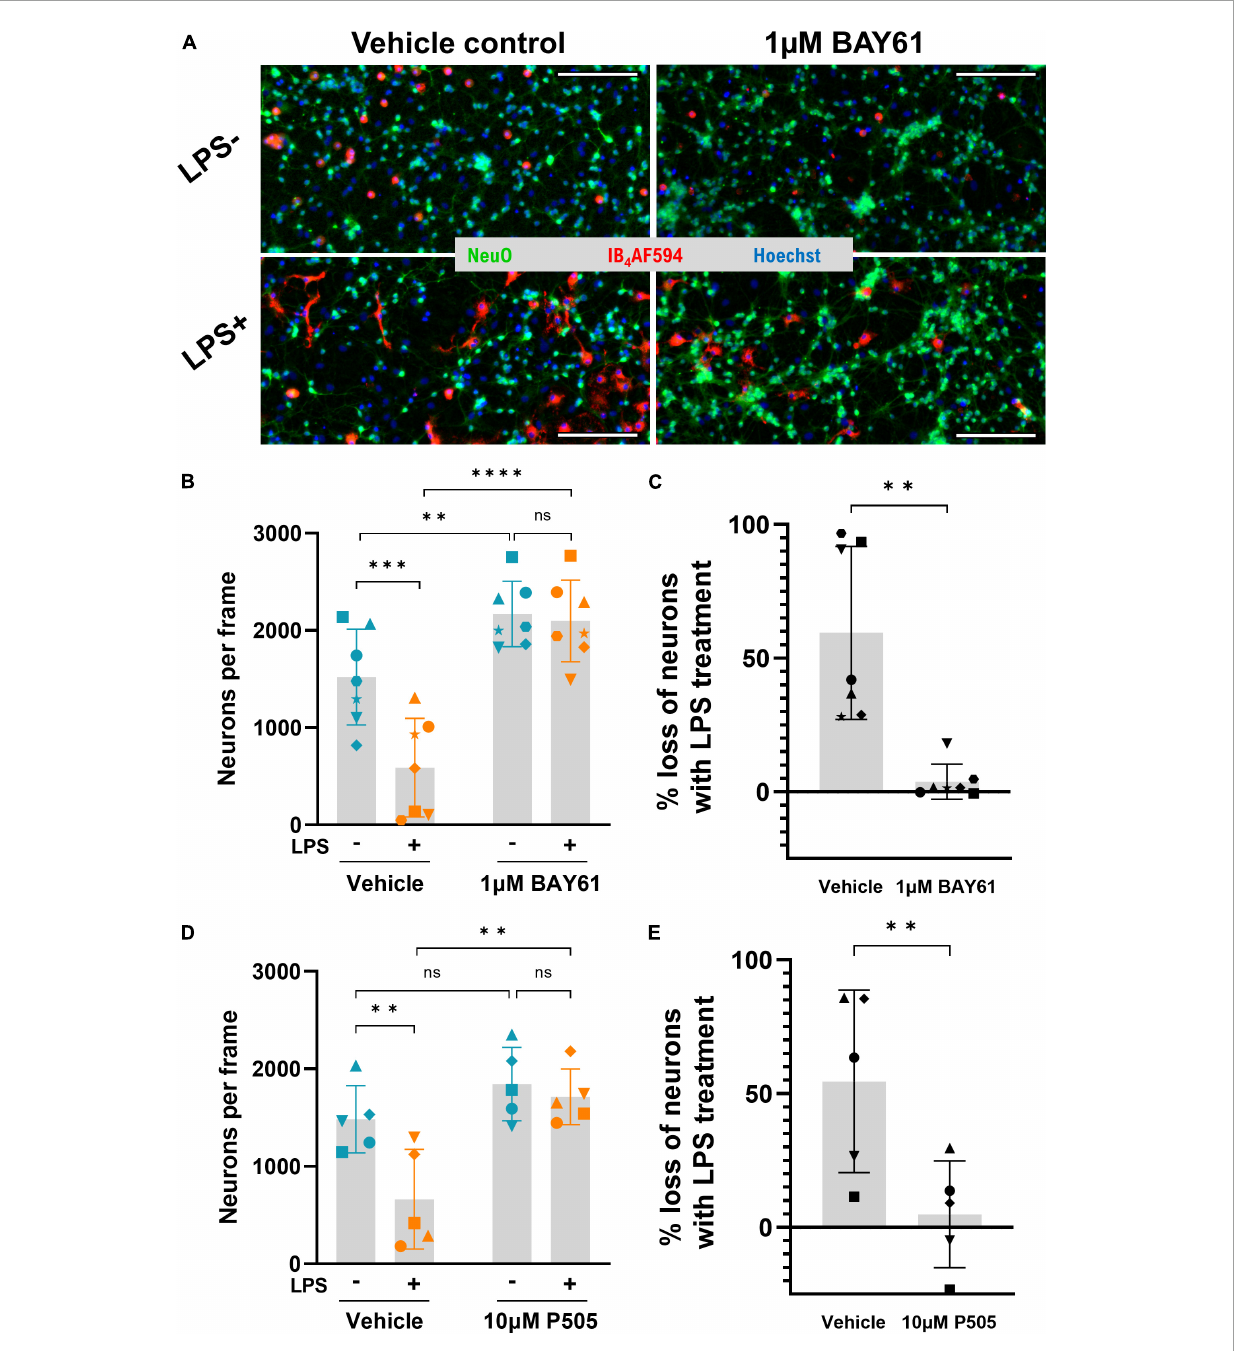
FIGURE1 Syk inhibitors prevent LPS-induced neuronal loss in primary neuron-glia cultures. (A) Representative 10 × images (cropped) of primary rat cerebellum neuron-glia cultures treated ± BAY61 (1 µ M) ± LPS (100 ng/ml) for 3 days and stained with Hoechst 33342 (nuclei), IB 4 -AF594 (microglia), and NeuO (live neurons). Scale bars = 100 µ m. (B) Average neuronal counts per image in cultures treated ± BAY61 (1 µ M) and ± LPS (100 ng/ml) for 3 days (DIV10). RM 2-way ANOVA with Šídák’s post-hoc test. (C) LPS-induced neuronal loss ± BAY61 calculated from the neuronal counts of (B) as percentage of neuronal counts in absence of LPS. Paired t -test. (D) Average neuronal counts per image in cultures treated ± P505 (10 µ M) and ± LPS (100 ng/ml) for 3 days (DIV10). RM 2-way ANOVA with Šídák’s post-hoc test. (E) LPS-induced neuronal loss ± P505 from the neuronal counts of (D) as percentage of neuronal counts in absence of LPS. Paired t -test. All panels: each datapoint represents the mean of three technical replicates. Number of biological repeats = number of datapoints per column. ∗∗ p < 0.01, ∗∗∗ p < 0.001, ∗∗∗∗ p < 0.0001.